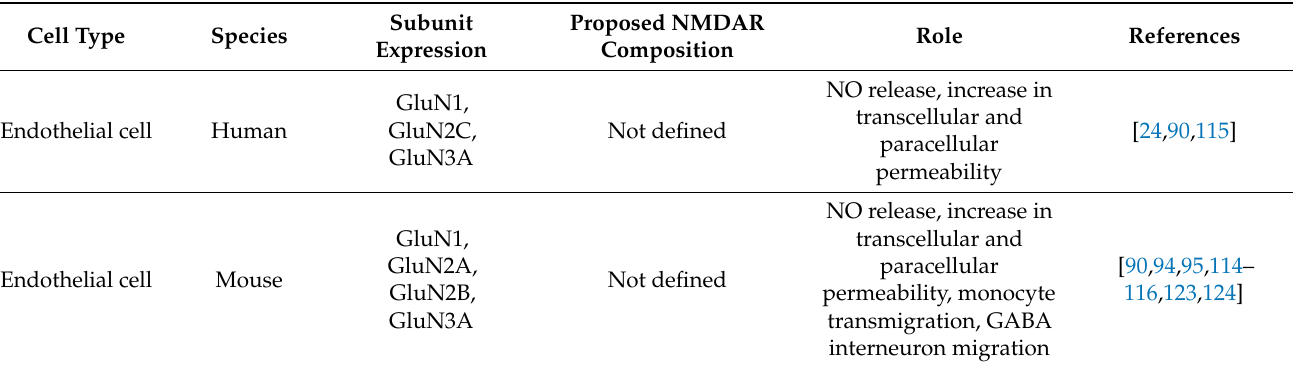
Table 3. NMDARs in cerebrovascular endothelial